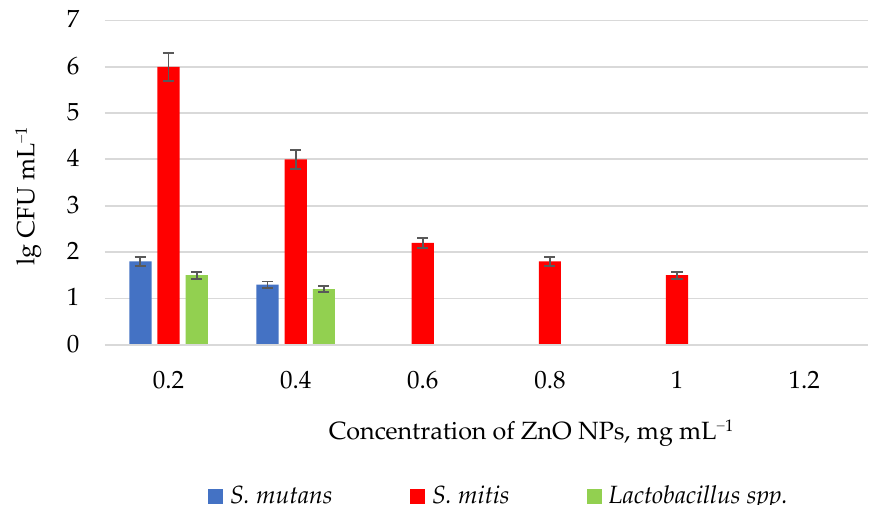
Figure 3. Effects of ZnO NPs (lg CFU mL − 1 ) on the growth of S. mutans (blue), S. mitis (red), and Lactobacillus spp. (green) in the thioglycolate broth after 18 h at 37 ◦ C under microaerophilic conditions [72].